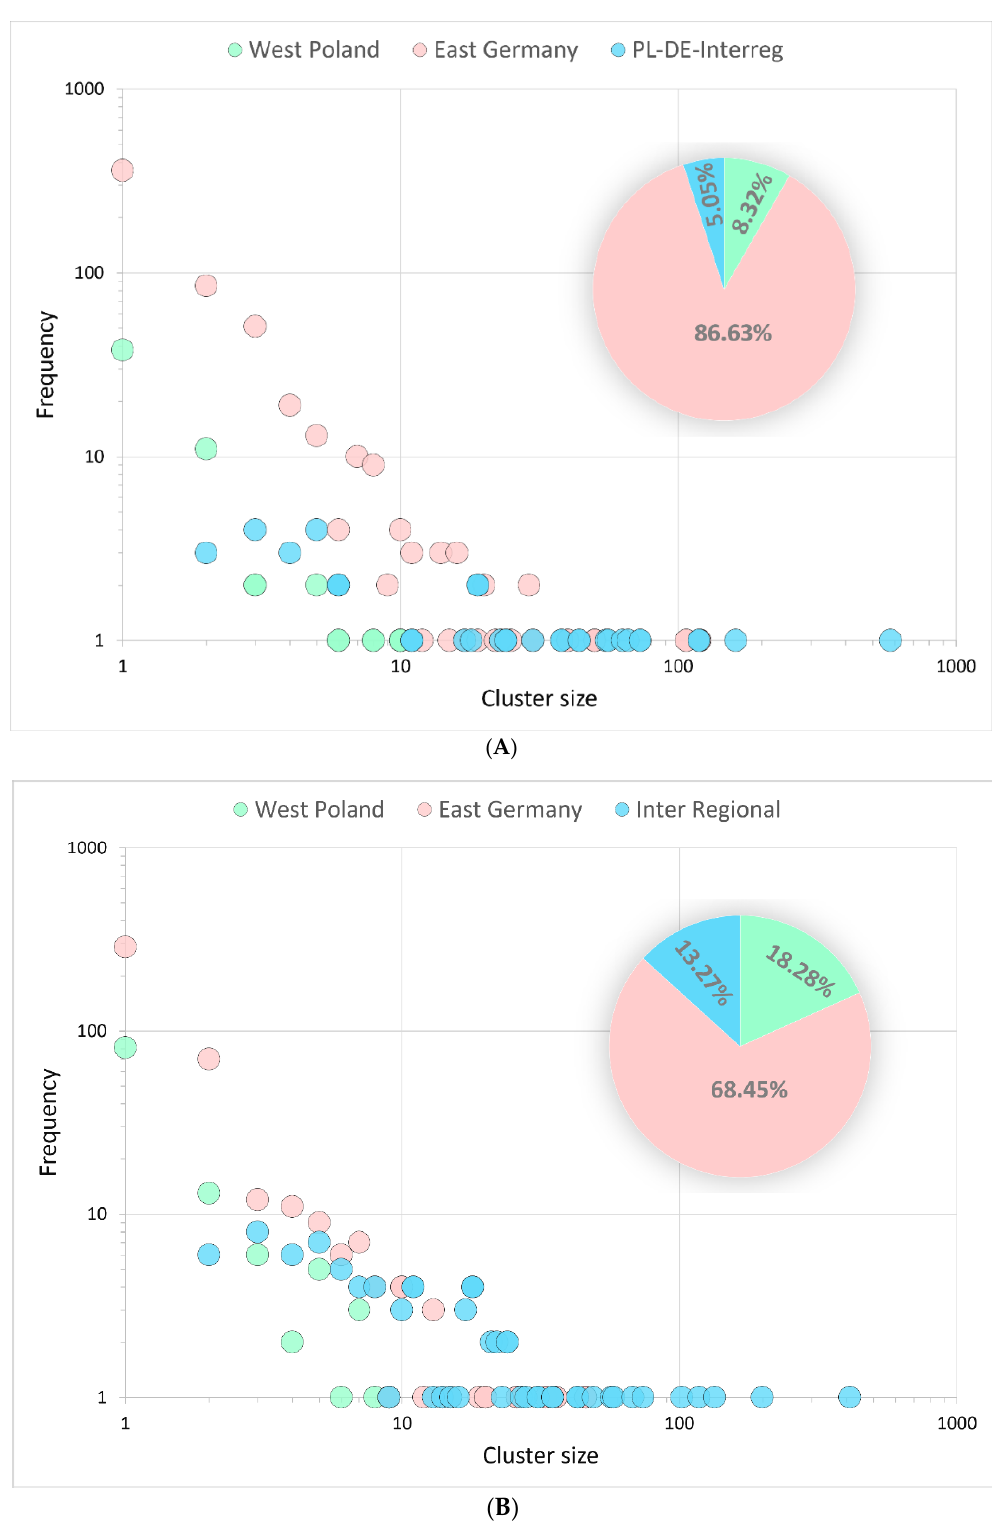
Figure 4. The cluster size (number of sampled sequences) distribution of the non-Alpha lineages ( A ) and Alpha VoC ( B ) circulating in the Polish – German border area. The clusters are assigned to the country of origin, containing only Polish, German, or interregional sequences (at least one from Poland and one from Germany). The pie charts show the percentage of clusters identified for a given location.